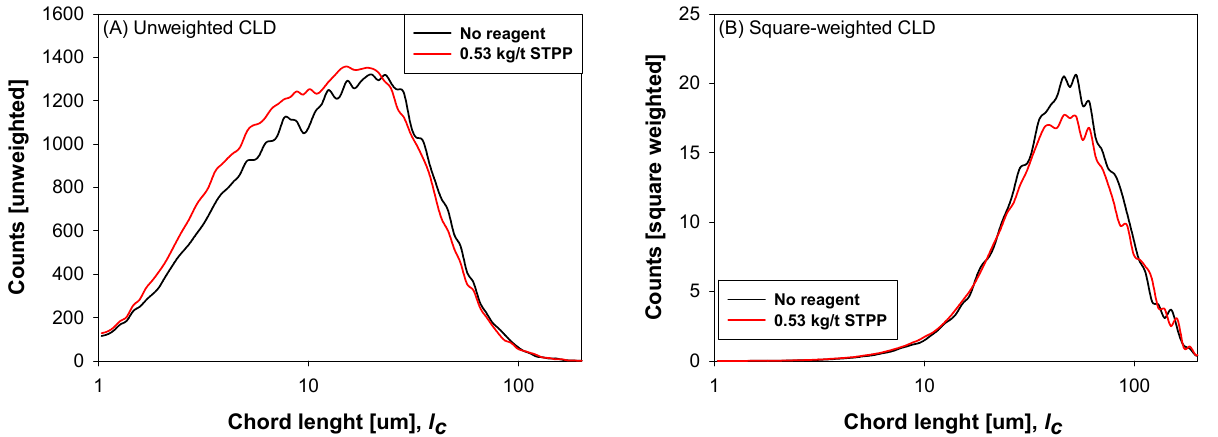
Figure 5. Effect of sodium tripolyphosphate on chord-length distribution of kaolin slurries: ( A ) unweighted chord-length distribution; ( B ) square-weighted chord-length distribution.